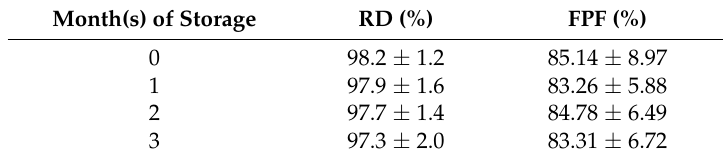
Table 4. Aerodynamic behavior of ND 2 after storage in an accelerated condition ( n =